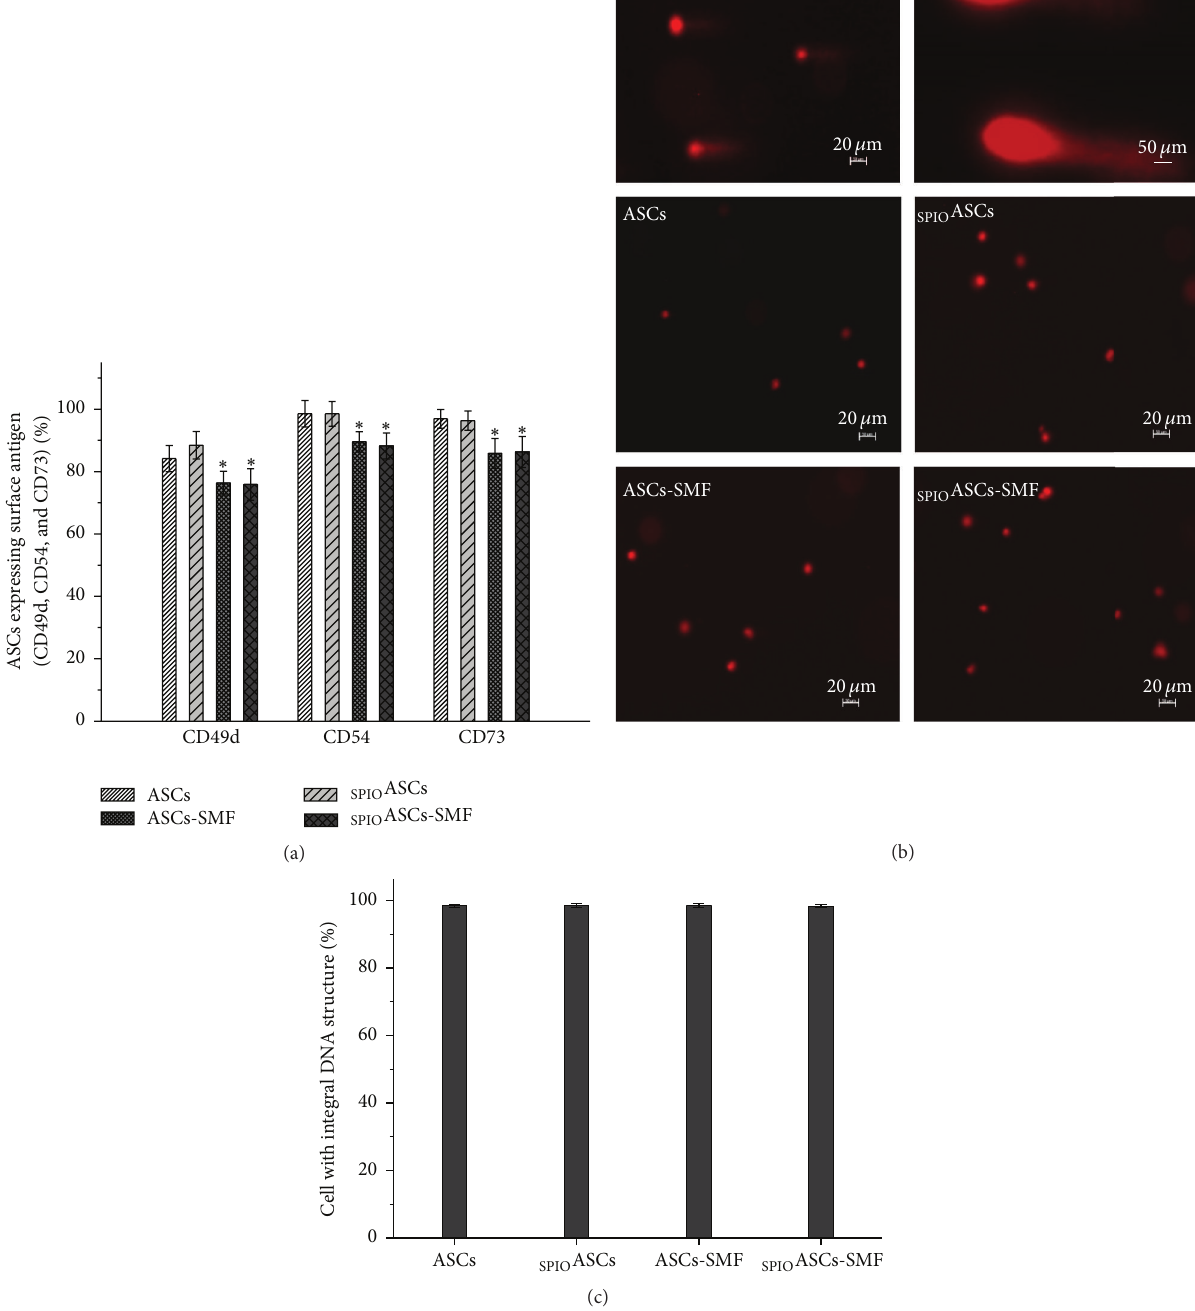
Figure 4: Effect of seven-day exposure to 0.5 T SMF on surface antigen profile and DNA integrity in ASCs and SPIO ASCs. (a) The percentage of cells expressing CD49d, CD54, and CD73 was significantly lower in the ASCs-SMF and SPIO ASCs-SMF than in the ASCs and SPIO ASCs. (b) Representative comet assay result. DNA damage with comet tail was not observed at four groups of ASCs. (c) The percentages of cell with integral DNA structure did not differ among ASCs, SPIO ASCs, ASCs-SMF, and SPIO ASCs-SMF. Scale bar represents 20 𝜇 m or 50 𝜇 m. ∗ 𝑃 < 0.05 versus ASCs or SPIO